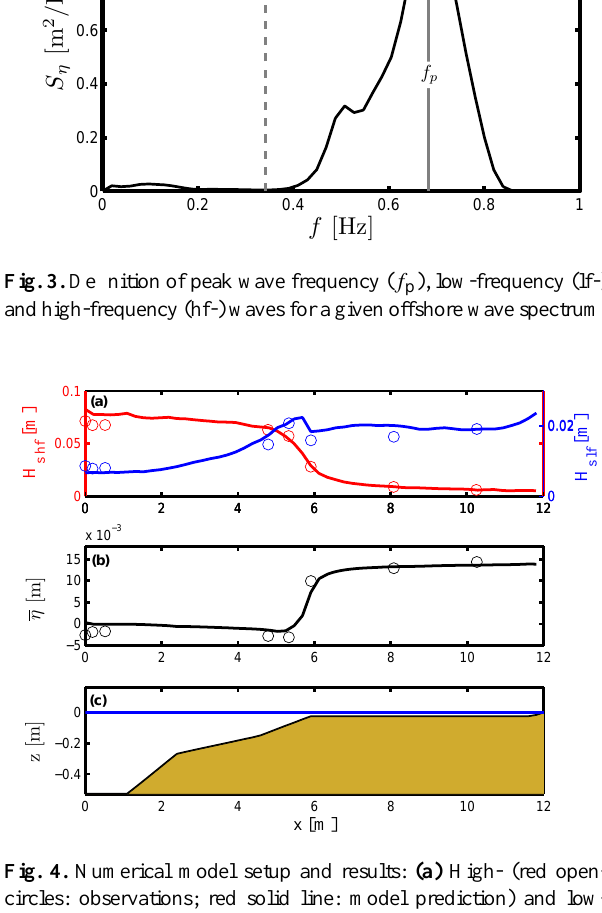
level statistics is found, with a mean relative error of 7% for all cases. Larger discrepancies (relative errors of 29%, 13 %, and 13 %) between measured and predicted water level statistics ( H s hf , η , and H s lf ) are found in the less energetic case (i.e. Test 26), whereas relative errors of only 6% are found for other cases (e.g. Test 29). By conducting a sensitiv- ity analysis, with different values of c f , we found no signifi- cant differences when the c f value is halved (i.e. c f = 0.001), whereas increasing the c f value by one order of magnitude ( c f = 0.01) decreases both the hf- and lf-wave height by 18 % and 32 %, respectively, whereas the wave setup remained